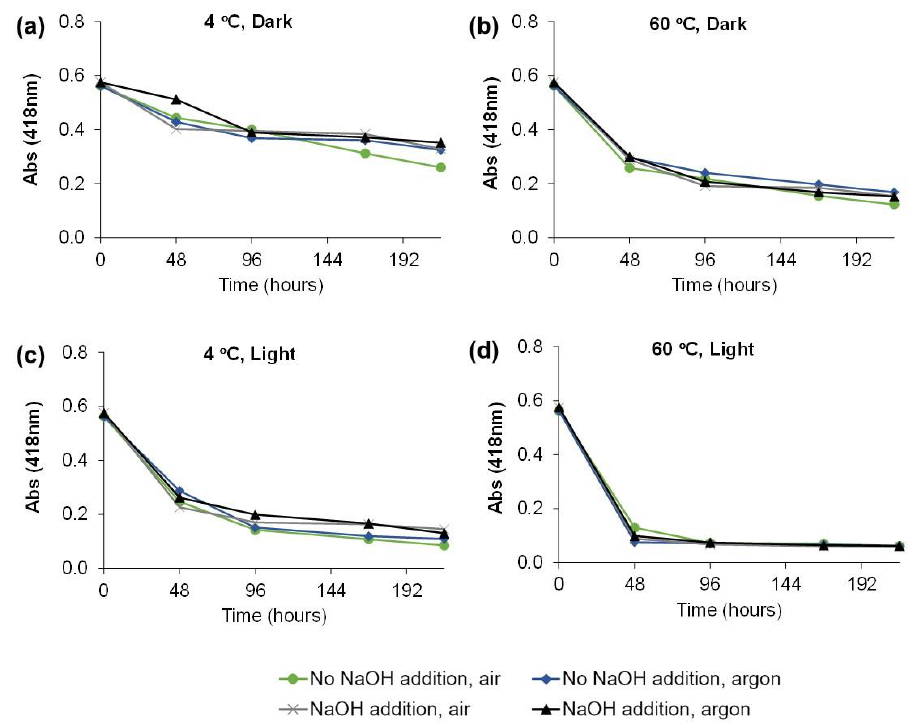
Figure 3. Absorbance (418 nm) measured over time for the 16 experimental conditions ( a ) 4 °C, Dark, ◦ C, Dark, ( c ) 4 ◦ C, Light, ( d ) 60 ◦ C, ( b ) 60 °C, Dark, ( c ) 4 °C, Light, ( d ) 60 °C, Light. ( b ) 60